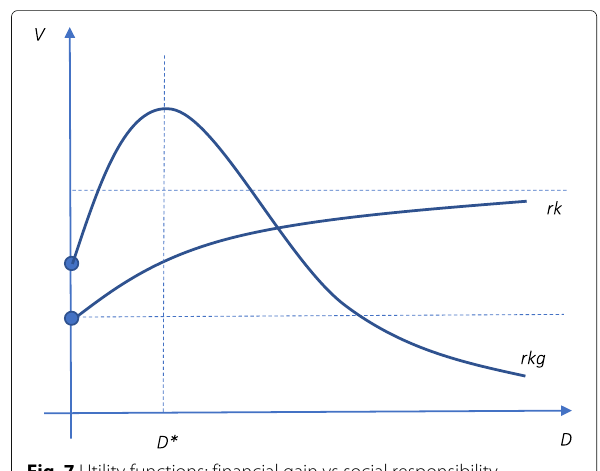
Fig. 7 Utility functions: financial gain vs social responsibility